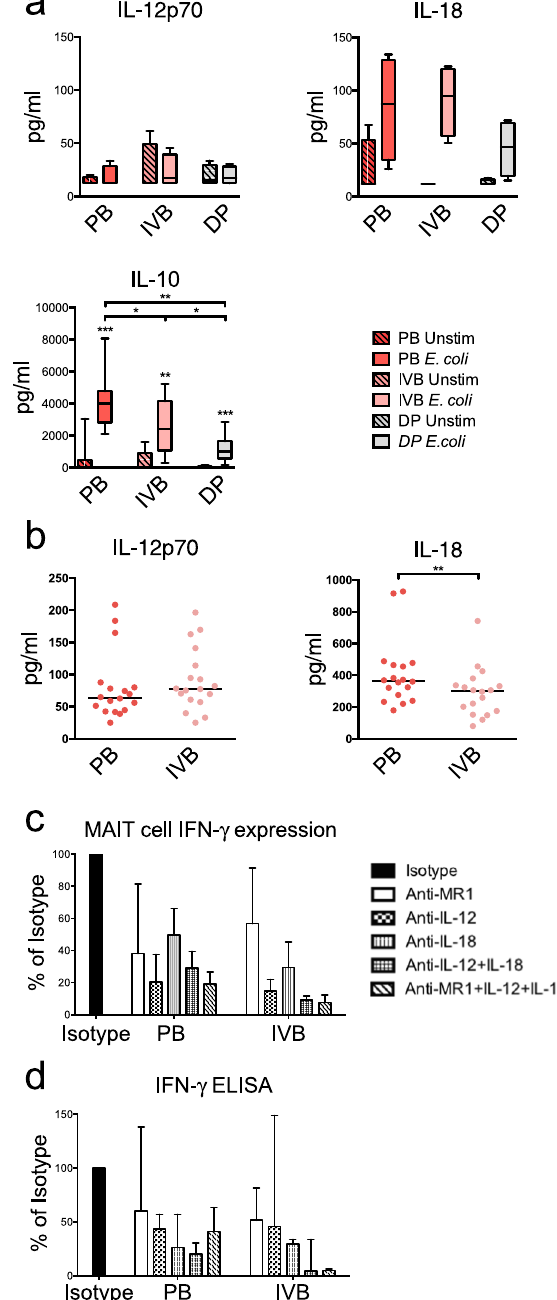
Figure 4. IL-12p70 and IL-18 levels do not correlate with higher MAIT cell responses in IVB compared to PB ( a ) Levels of IL-12p70 (top left, n = 4), IL-18 (top right, n = 4) and IL-10 (bottom left, n = 10) in culture supernatants from paired samples of PB, IVB, and DP following 16 hours of culture with or without E . coli stimulation. ( b ) Levels of IL-12p70 (left, n = 18) and IL-18 (right, n = 18) in paired plasma samples from PB and IVB measured with ELISA. ( c , d ) The effect of IFN- γ production in paired samples of PB and IVB following 16 hours of culture with E . coli stimulation after addition of indicated neutralizing antibodies. Data is expressed as percentage cytokine release compared to appropriate isotype control (black). ( c ) Flow cytometric analysis of intracellular MAIT cell expression of IFN- γ (anti-MR1 n = 5, anti-IL-12 n = 3, anti-IL-18 n = 2, anti-IL-12 + IL-18 n = 2, anti-MR1 + IL-12 + IL-18 n = 3). ( d ) Levels of IFN- γ measured with ELISA on culture supernatants (anti-MR1 n = 4, anti-IL-12 n = 4, anti-IL-18 n = 4, anti-IL-12 + IL-18 n = 3, anti-MR1 + IL-12 + IL-18 n = 4). Box and whisker plots show median, interquartile range and range of paired samples. In ( a ) and ( b ), the Wilcoxon signed rank test was used to detect statistically significant differences between paired unstimulated and stimulated samples ( a ), or two different groups ( b ), stars indicate significances. The Friedman test followed by the Wilcoxon signed rank test was used to detect statistically significant differences across multiple paired samples ( a ). A Bonferroni corrected p value was used for multiple comparisons. * P < 0.05, ** P < 0.01, *** P <